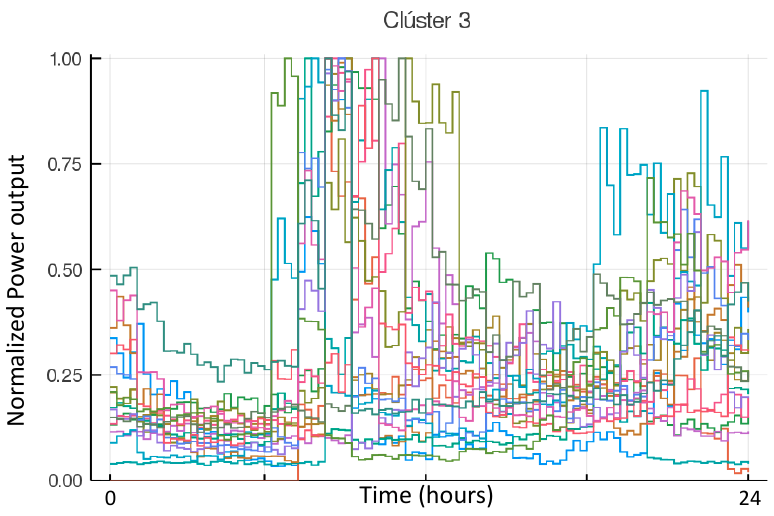
Figure 8. Data of 362 actual distribution customers from Santiago, Chile. Cluster 3.